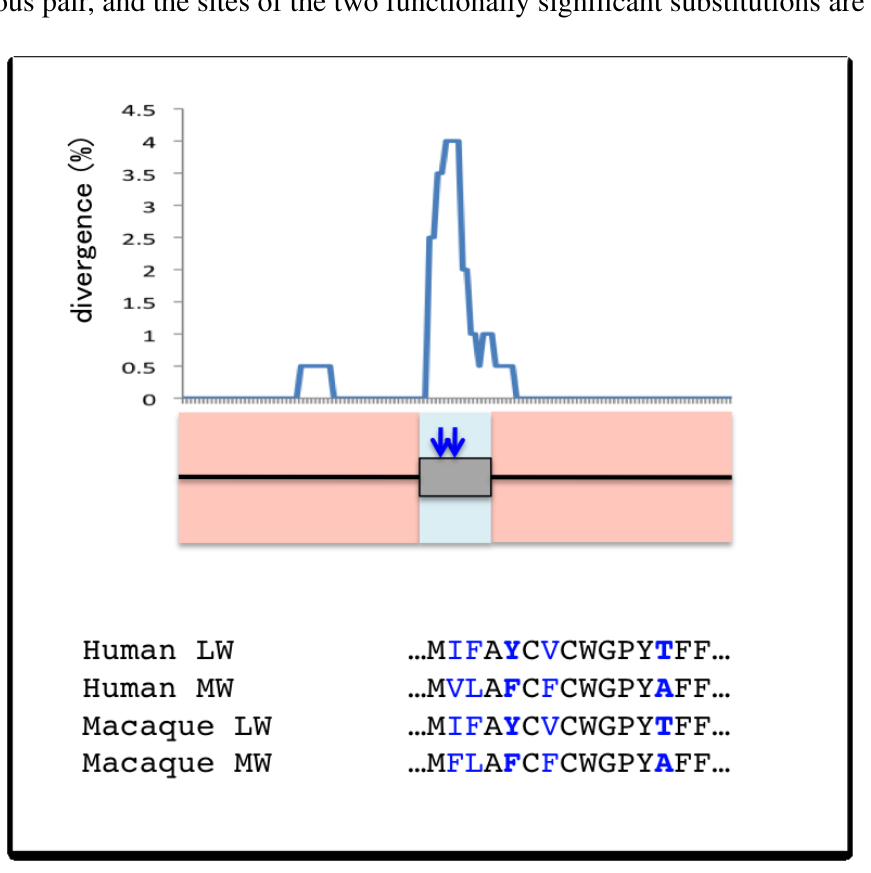
Figure 5. Sequence divergence of the red- and green-opsin genes in human and macaque. The graph shows the divergence between the human red-opsin (long-wave: LW) and green-opsin (medium-wave: MW) genes of intron 4, exon 5, and intron 6. The divergence data was taken from [46]. The gene structure of the region is shown below with the introns 4 and 6 represented by black lines and the exon 5 represented by a gray box. Regions where the similarity is higher between paralogs of the same species than between orthologs of other species ( i.e. , the introns) due to frequent gene conversion is in a light red background, whereas regions where the similarity is higher between the orthologs than the paralogs ( i.e. , the exon) are in a light blue background. The two blue arrows indicate the positions of the two fixed amino acid substitutions that are largely responsible for the difference in color sensitivity [53]. The amino acid sequences of the red-opsin (LW) and green-opsin (MW) genes of human and macaque [49] around the two functionally significant substitutions are shown below. The sites in blue are sites where the difference is fixed between either of the orthologous pair, and the sites of the two functionally significant substitutions are in